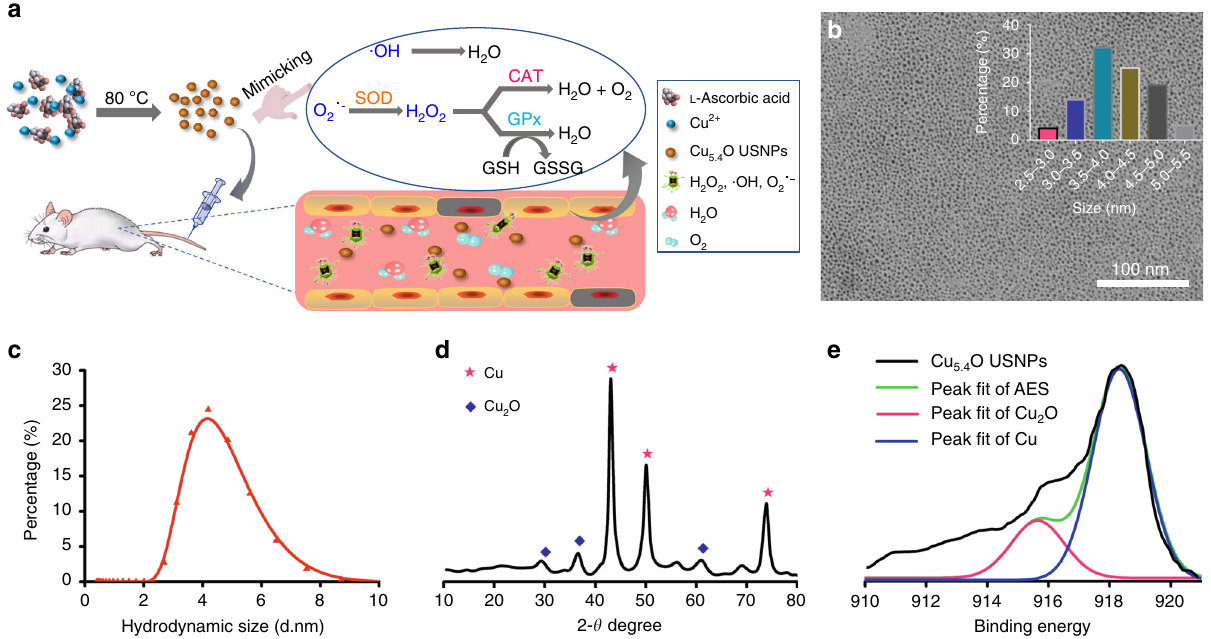
Fig. 2 Preparation and characterization of Cu 5.4 O USNPs. a Schematic preparation of Cu 5.4 O USNPs. b TEM image of Cu 5.4 O USNPs. Inset is the statistical chart of particle size distribution. The cross-sectional area of each particle was measured by using ImageJ Software from the TEM images, with at least 500 particles counted per sample. c Hydrodynamic diameter distribution of the Cu 5.4 O USNPs. d X-ray diffraction (XRD) pattern of the Cu 5.4 O USNPs, the rhombus, and star symbols represent the characteristic peaks of Cu 2 O and Cu, respectively. e XAES spectra of the Cu 5.4 O USNPs. Source data are provided as a Source Data fi